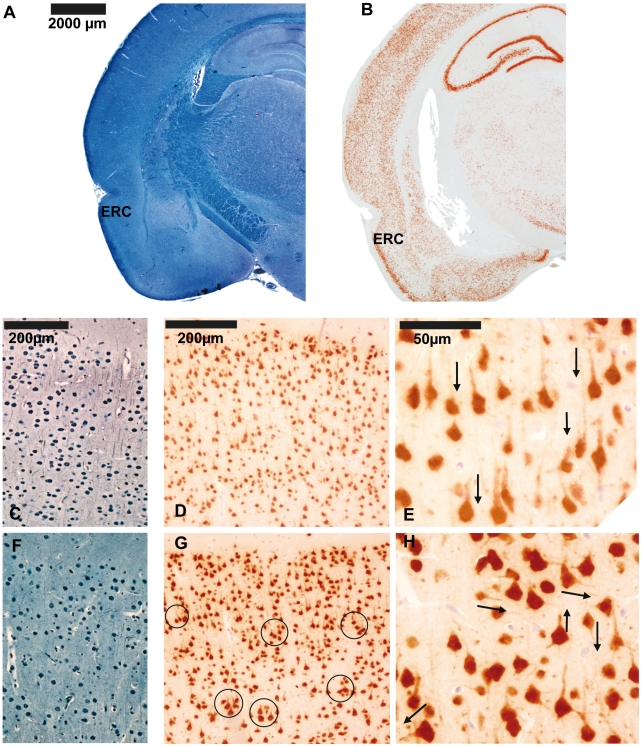
Neuronal organization of entorhinal cortex in MAM and control rats.Coronal sections of the entorhinal cortex at Bregma −3.8mm from control animals stained with Bodian-Luxol (A) and NeuN immunostaining (B). (C) Bodian-Luxol staining of the entorhinal cortex from control animals. A well defined columnar organization and myelin with parallel directions can be observed. Arrows point to myelin pathways. (D) Anti-NeuN immunostaining of the entorhinal cortex from control animals showing axon hillocks with a parallel orientation and neuronal bodies regularly organized. (E) Neuronal somas and axon hillocks are clearly distinguished in this picture magnified 400×. Arrows point to axon-hillock direction. (F) Bodian-Luxol staining of the entorhinal cortex from MAM rats reveals a less obvious columnar organization while myelin direction appears random. (G) NeuN immunostaining of the entorhinal cortex from MAM animals. Neuronal disorganization with clusters of neurons is evident mainly in layers II and III. Circles highlight neuronal clusters. (H) Neuronal disorganization, neuronal size variability and axon hillocks with random directions can be observed in this picture magnified 400×. Arrows point to axon-hillock direction.